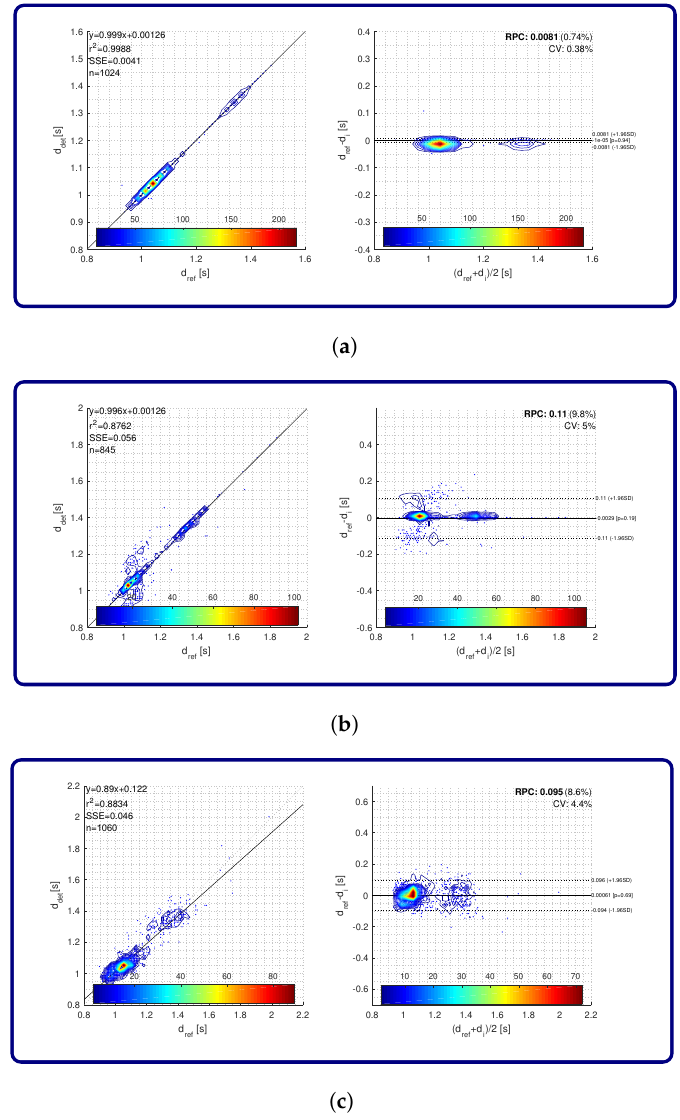
Figure 12. Regression analysis and Bland–Altman plots for accuracy on gait event extraction from the eGait data: ( a ) toe-off; ( b ) heel-strike; and ( c ) mid-stance. Colour map represents the number of